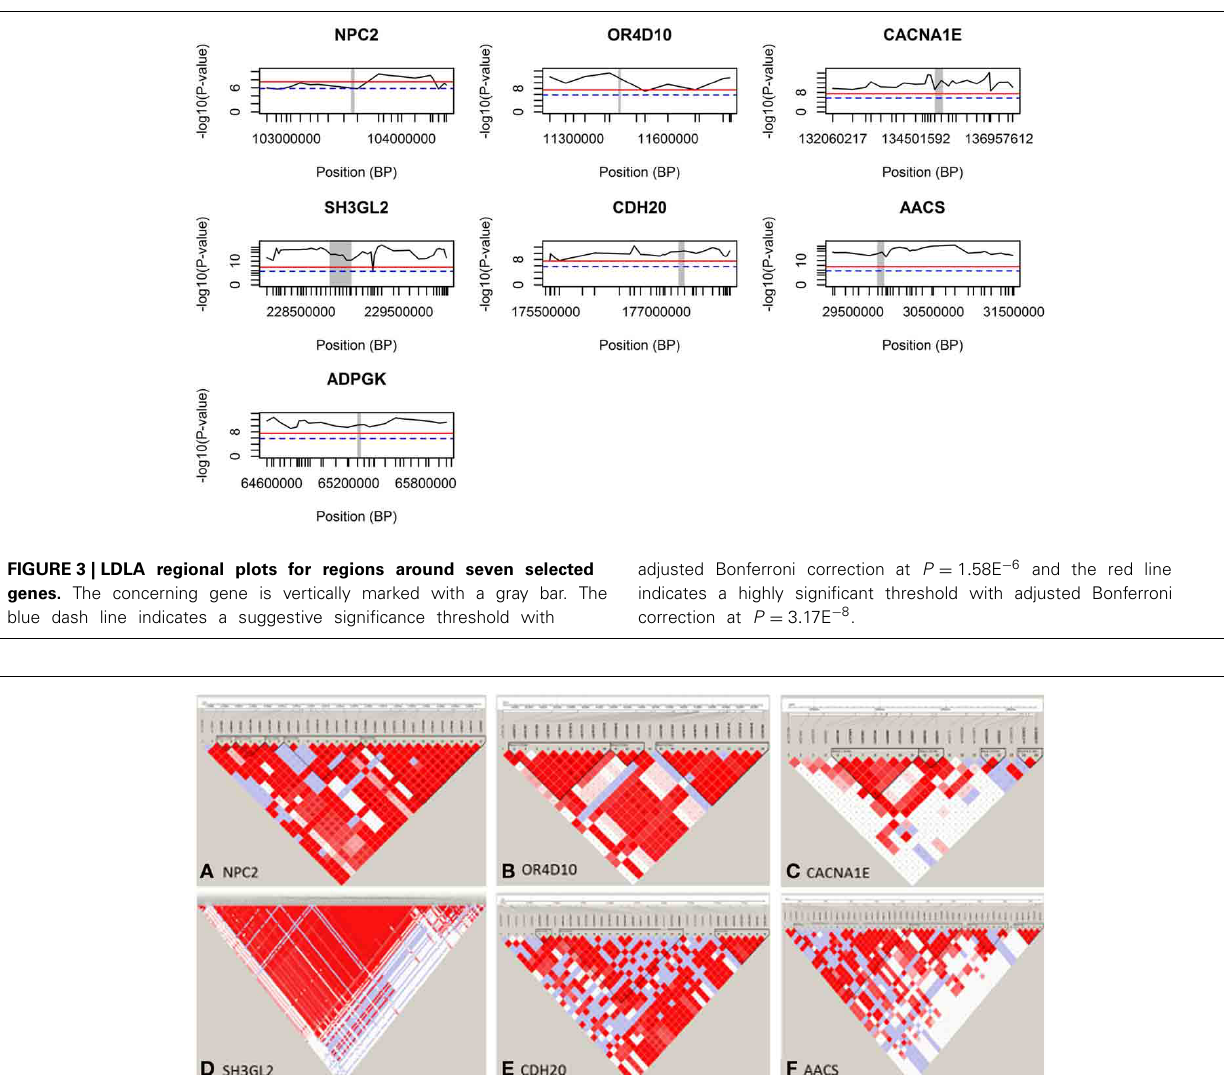
FIGURE 4 | Haploview representation of regional haplotype block estimates of seven selected regions, detected by GWA analysis. On the vertical line the SNPs present in the selected region, and the triangles (black lines) represent the haplotype blocks. (A) NPC2 gene is located in a 8-SNP haplotype block of 4Kb size on Chromosome 7; (B) OR4D10 gene is located in a 9-SNP haploype block of 10Kb size on Chromosome 2; (C) CACNA1E